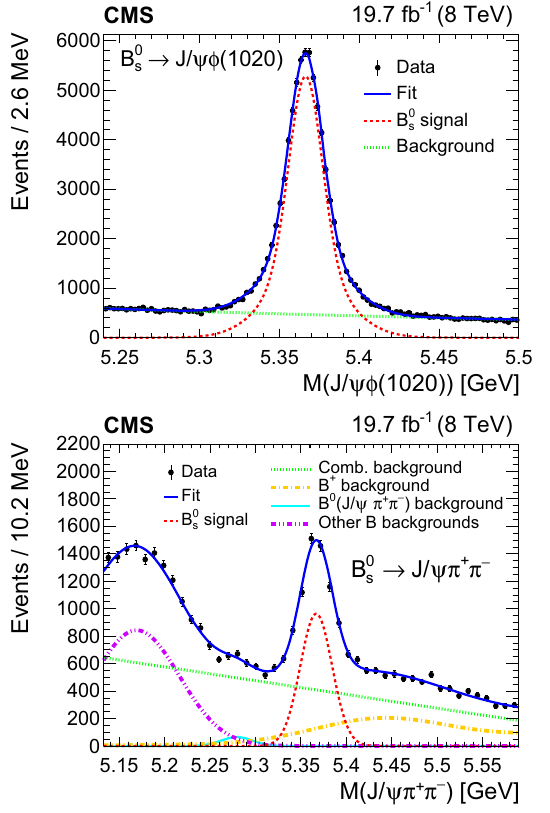
Fig. 4 Invariant mass (left) and ct (right) distributions for B 0 s candi- dates reconstructed from J /ψφ( 1020 ) (upper) and J /ψπ + π − (lower) decays. The curves are projections of the fit to the data, with the full fit function (solid) and signal (dashed) shown for both decays, the total background (dotted) shown for the upper plots, and the combi- natorial background (dotted), misidentified B + → J /ψ K + background